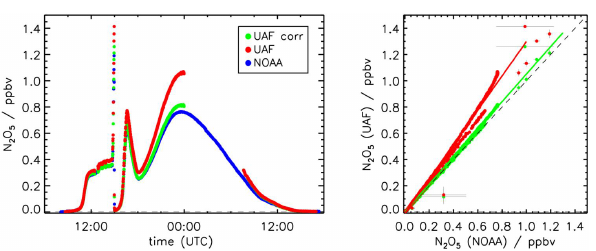
Fig. 5. Statistical analysis of the relative difference of N 2 O 5 mea- surements between UAF-CRDS, UCB-LIF instruments and NOAA- CRDS ( 1 N 2 O 5 =N 2 O 5 − N 2 O 5 (NOAA)) depending on the water vapor mixing ratio on 10 June (maximum relative humidity 40%). The water vapor mixing ratio was increased in several steps, which correspond to the boxes shown here. Dots are medians and boxes give the 25 to 75 percentiles of the distribution.